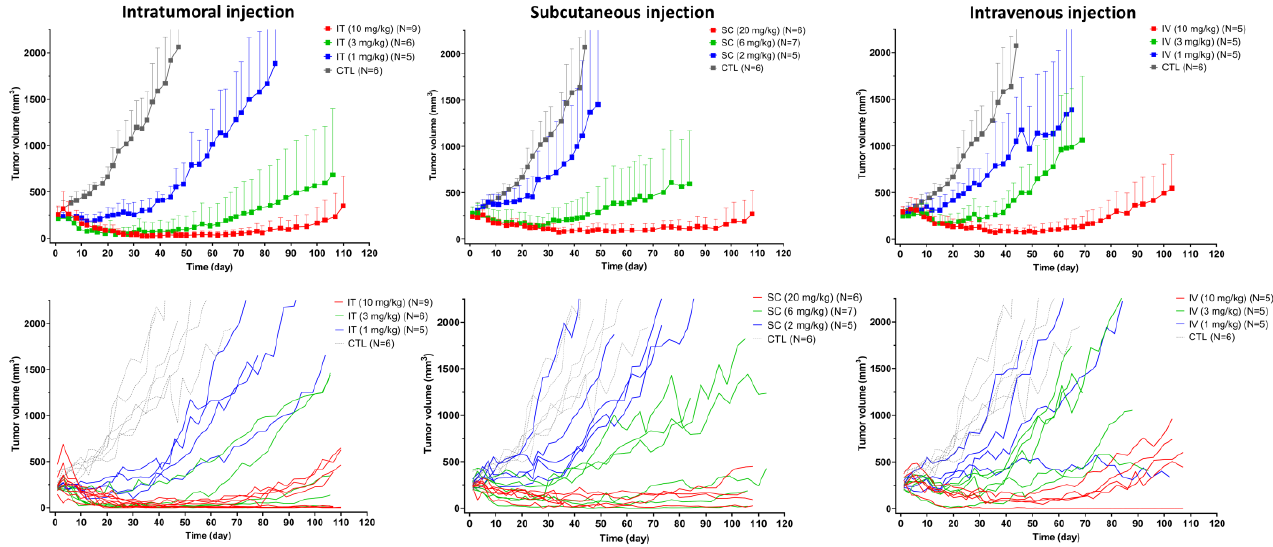
Figure 5. In vivo efficacy of T-vc-MMAE ADC after intravenous (IV), intratumoral (IT), and subcutaneous (SC) administration. The figures show the mean (SD) tumor growth curves (upper) and individual tumor growth curves from each animal (lower) after IT (10, 3, 1 mg/kg), SC (20, 6, 2 mg/kg), and IV (10, 3, 1 mg/kg) administration of T-vc-MMAE single dose, along with the untreated group.